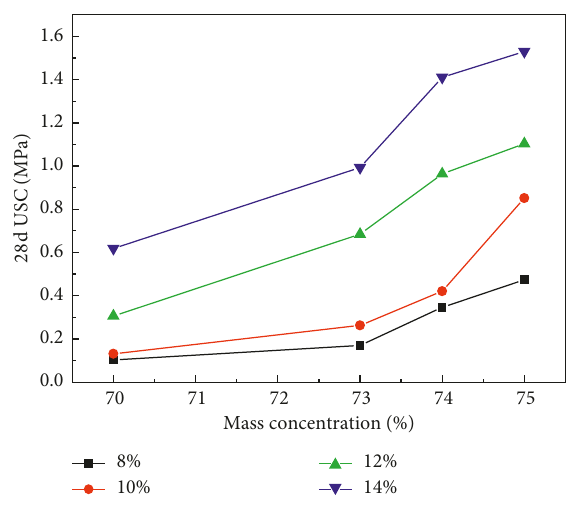
Figure 8: UCS of the mass concentration at